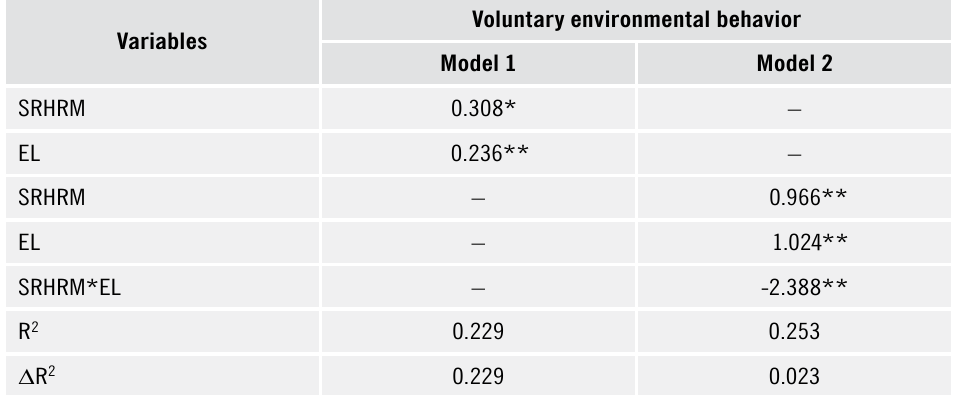
Table 4. Moderating effect of ecocentric